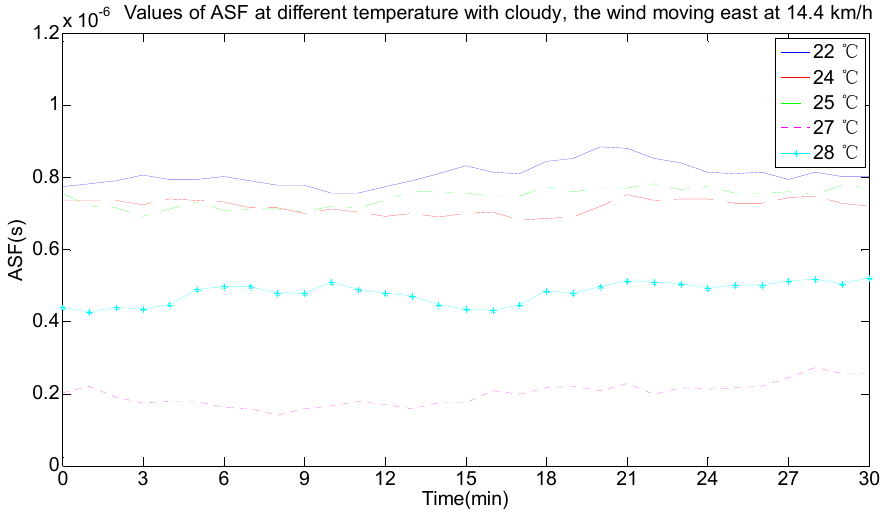
Figure 12. ASF values changing with different temperature conditions.